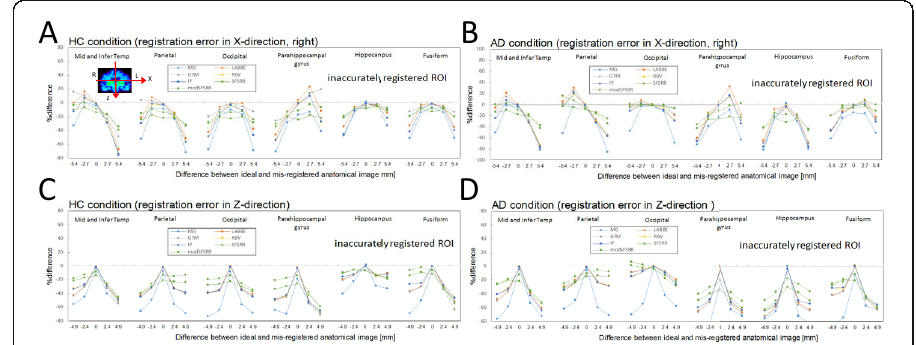
Fig. 6 %difference of PVC-SUVRs with registration error ( X ) against true SUVRs. a HC condition and b AD condition and %difference of PVC-SUVRs with registration error ( Z ) against true SUVRs: c HC condition and d AD condition. ROI template was from inaccurately registered anatomical